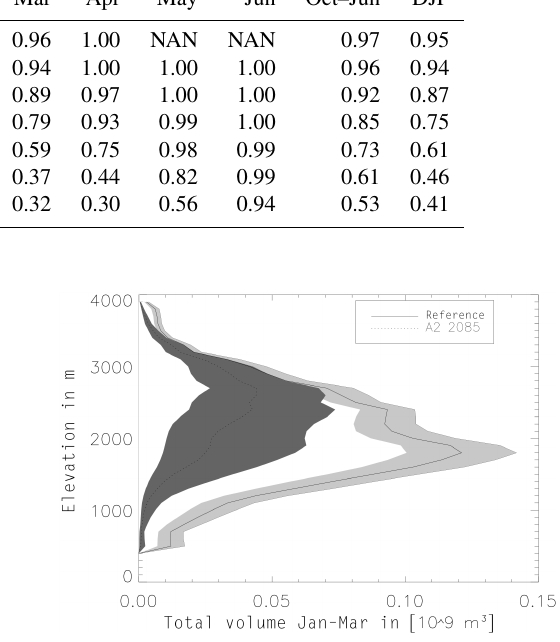
Figure 6. Total volume of snow (January–March) in the Aare region for today (solid line) and the end of the century (dotted line). The shaded area for the reference period indicates half of the standard deviation (for readability) of the interannual variability. The shaded area of the 2085 scenario period indicates the range between the lowest and highest estimate based on the A2 emission scenario (Ta- ble